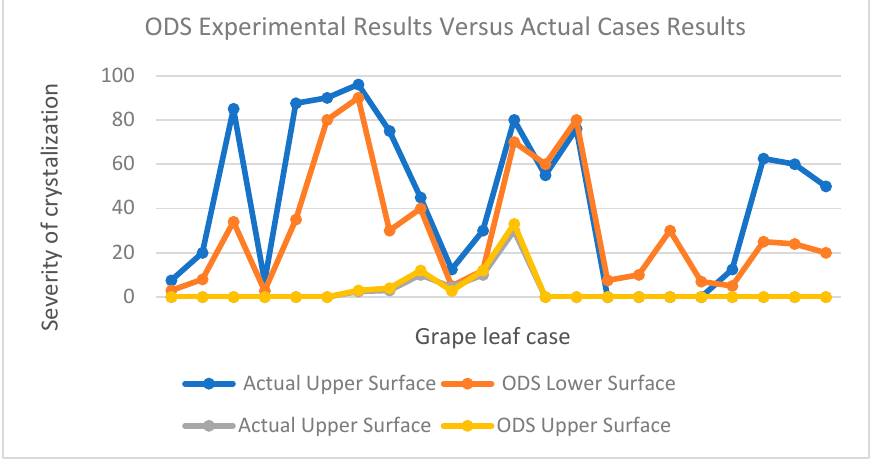
Figure 8. Experimental results obtained using ODS versus those provided by an actual agronomist.